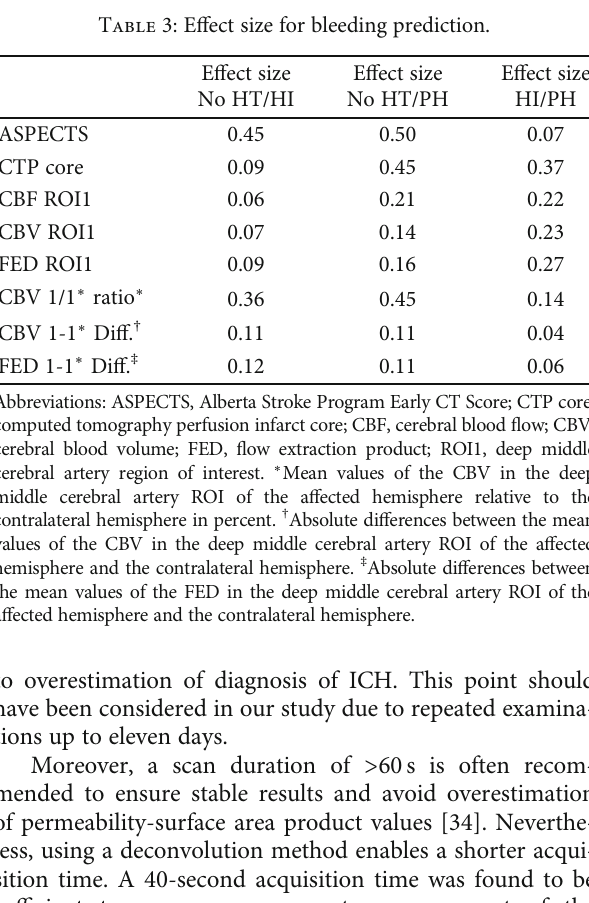
Figure I: (A) Time between admission and initial manifesta- tion of HT in the follow-up imaging in days. (B) Time between admission and the largest manifestation of HT in the follow-up imaging in days. HI1: hemorrhagic infarction 1, HI 2: hemorrhagic infarction 2, PH: parenchymal hema- toma 1, and PH2: parenchymal hematoma 2. Table I: CTP parameters in the deep middle cerebral artery region of interest. Abbreviations: CBF, cerebral blood fl ow; CBV, cere- bral blood volume; Tmax, maximum enhancement time; FED, fl ow extraction product; and ROI, region of interest.